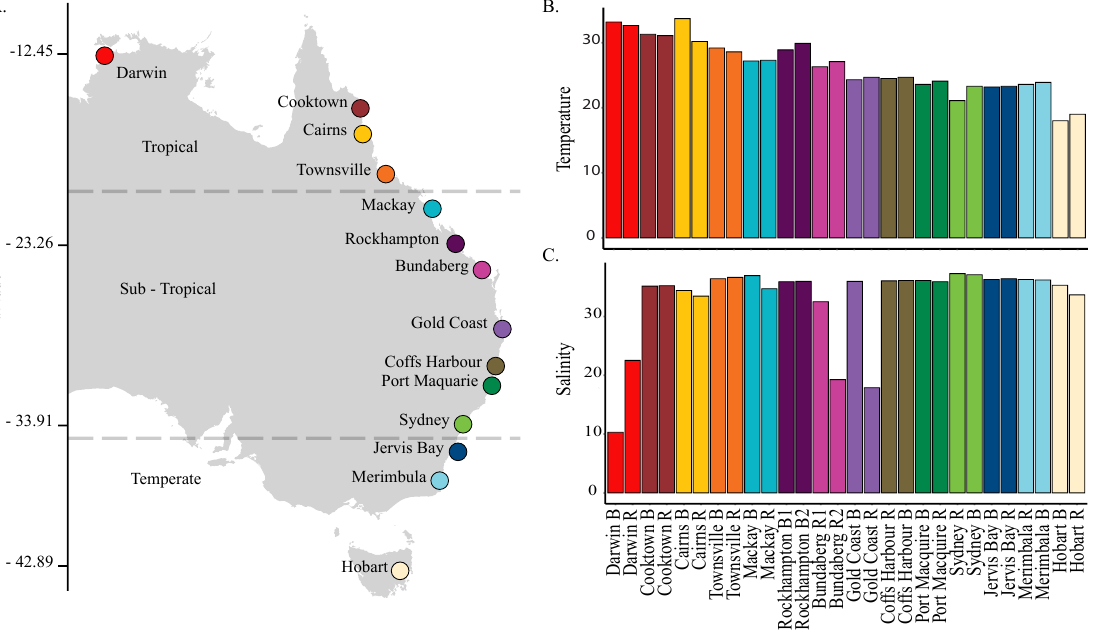
Figure 1. ( A ) Map of sampling locations. At each location, a sample was taken at the beach and in the river with the exception of Rockhampton where both samples were beach sites and Bundaberg where both sites were river sites. ( B ) Water temperature at each site in ◦ C. ( C ) Salinity at each site in ppt. At each sampling site, 10 L of water was collected from the surface in tinted, plastic drums, which had been pre-rinsed with bleach and then miliQ water and then rinsed three times on site prior to sampling. Physiochemical parameters including temperature, dissolved oxygen, salinity and pH were measured in situ using a WTW multiprobe meter (Multi3430, Wertheim, Germany). Triplicate water samples were filtered through 0.22 µ m pore size, 47 mm diameter filters (Millipore, DURAPORE PVDF. 22UM WH PL) using a peristaltic pump within 3 h of collection, with the volume of sample filtered recorded to allow for normalisation of gene copy numbers. Filters were immediately placed in dry ice, where they remained for the duration of the sampling trip. Upon returning to the lab, samples were stored at − 80 ◦ C until